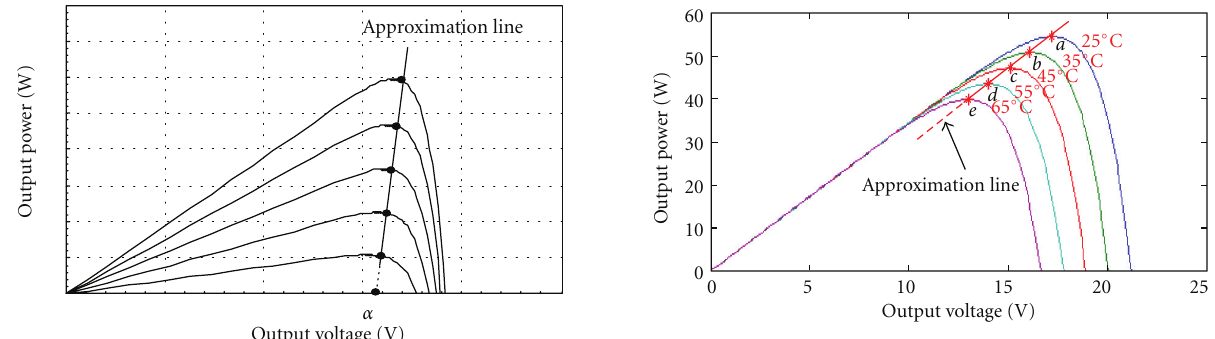
Figure 13: Illustration of the trajectory of maximum power point varying with temperature while insolation is constant.